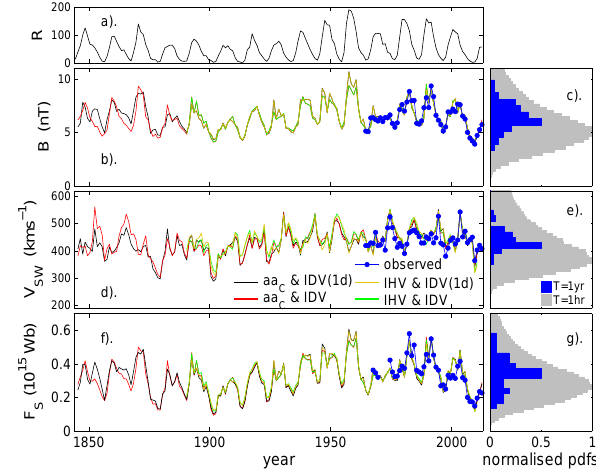
Fig. 6. The left-hand panels show time variations of annual means for the period 1845–2012 (inclusive) the right-hand panels show normalised probability distribution functions of annual means (in blue) and hourly values (in grey) from in situ observations (1966– 2012). (Note the distributions for annual means are shown on a halved scale for clarity.) (a) International sunspot number, R . (b) and (c) near-Earth IMF, B . (d) and (e) near-Earth solar wind speed, V SW . (f) and (g) the kinematically corrected signed open so- lar flux, F S . In (b) , (d) and (f) the reconstructions are based on the four combinations of pairs of geomagnetic activity indices analysed in the bottom panel in Fig. 4: IDV(1d) and aa C (black); IDV and aa C (red); IDV and IHV (orange); and IDV(1d) and IHV (green). The blue dots give annual means from satellite